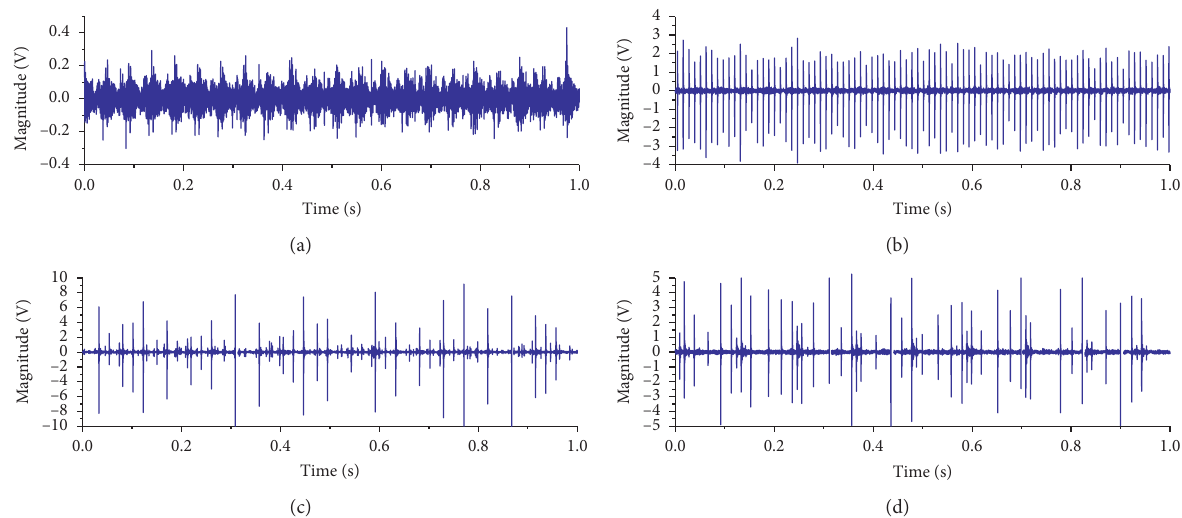
Figure 6: Vibration signals of REBs. (a) A normal REB and bearings with a point defect on (b) outer race; (c) inner race; (d) rolling element.